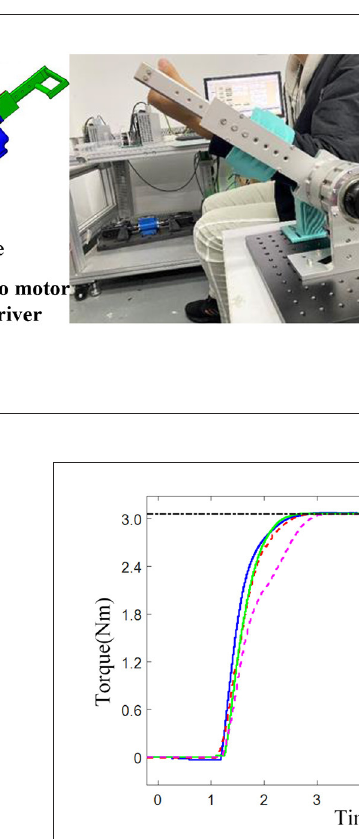
FIGURE13 Comparison of joint torque response using different control